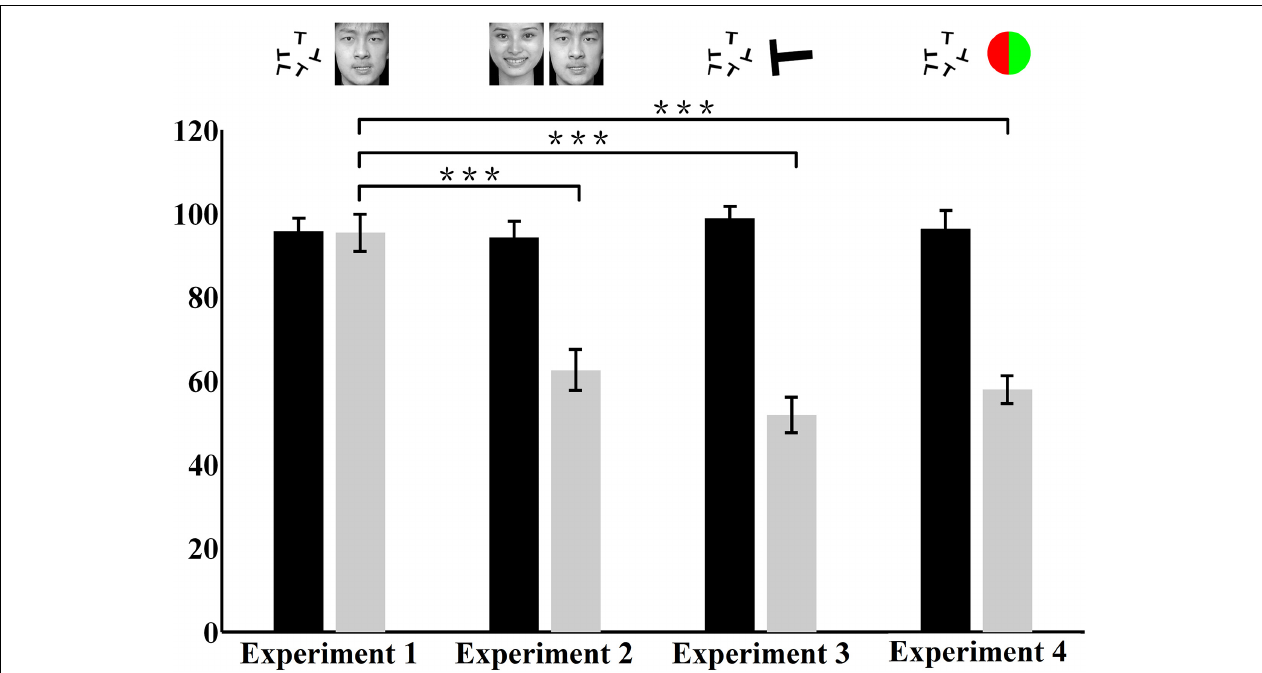
FIGURE 5 | Average central and peripheral performances in the four dual-task experiments. The vertical axis represents the accuracy rate. The black bar represents the performance of the attention-demanding central task. The gray bar represents the performance of the peripheral task. The accuracy rate is the normalized data. The stimuli presented in the central and peripheral tasks in the four experiments are illustrated above the corresponding bars. ∗∗∗ p < 0.0001.